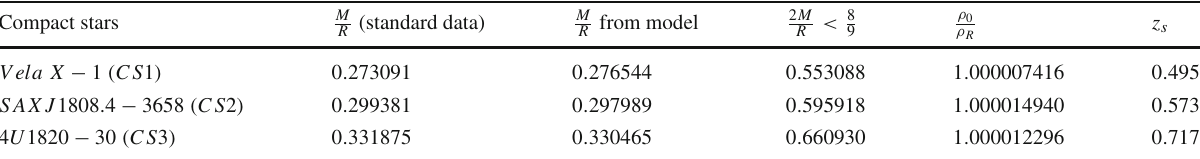
Table 8 Calculated values of the desired parameters of our model from Table 2 Compact stars M